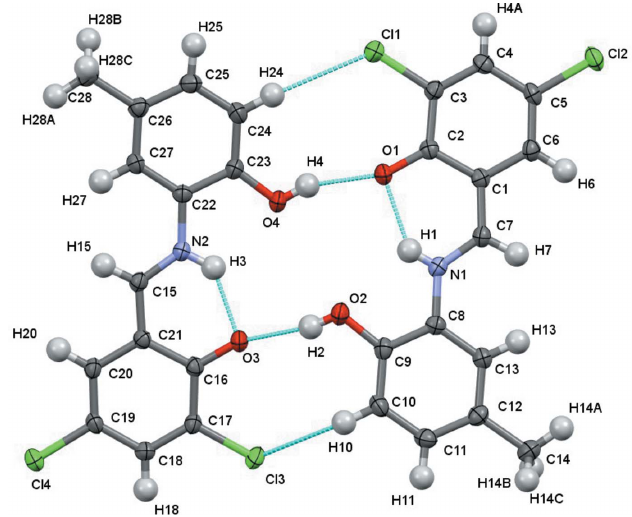
Figure 1 The asymmetric unit of the title compound, showing the atom labelling. Displacement ellipsoids are drawn at the 50% probability level and H atoms are drawn as spheres of arbitrary radii. Intermolecular C—H (cid:3)(cid:3)(cid:3) Cl and O—H (cid:3)(cid:3)(cid:3) O and intramolecular N—H (cid:3)(cid:3)(cid:3) O hydrogen bonds are indicated by dashed lines.